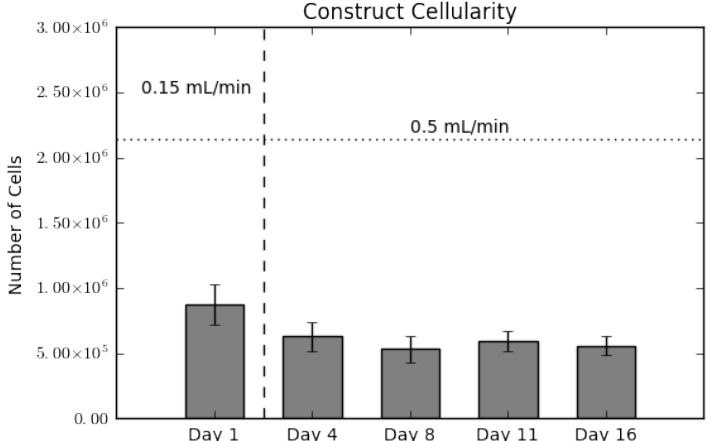
Figure 1. Construct cellularity for each construct over the culture period. The horizontal dashed line indicates the initial amount of cells seeded. The vertical dotted line indicates the switch in flow rates, from 0.15 mL/min during seeding to 0.5 mL/min for culture. Values are given as the mean ± the standard error of the mean ( n = 4).